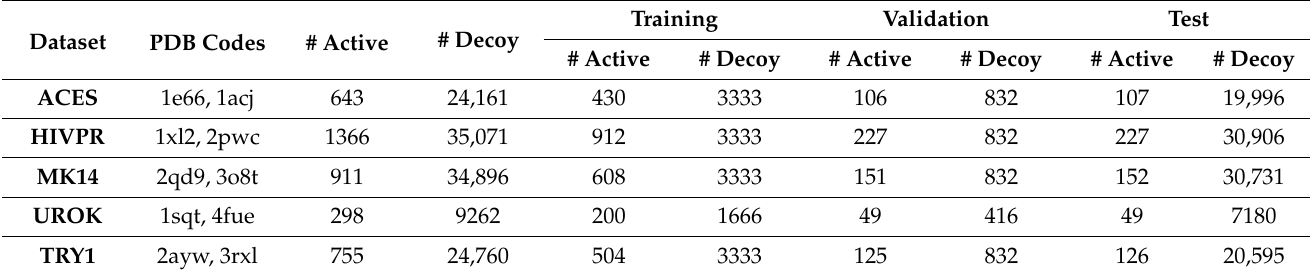
Table 5. Descriptions of the five datasets used in this work, including the numbers of active and decoy compounds in training, validation and test sets. The UROK dataset had fewer active/decoy compounds listed in DUD-E in comparison with all other